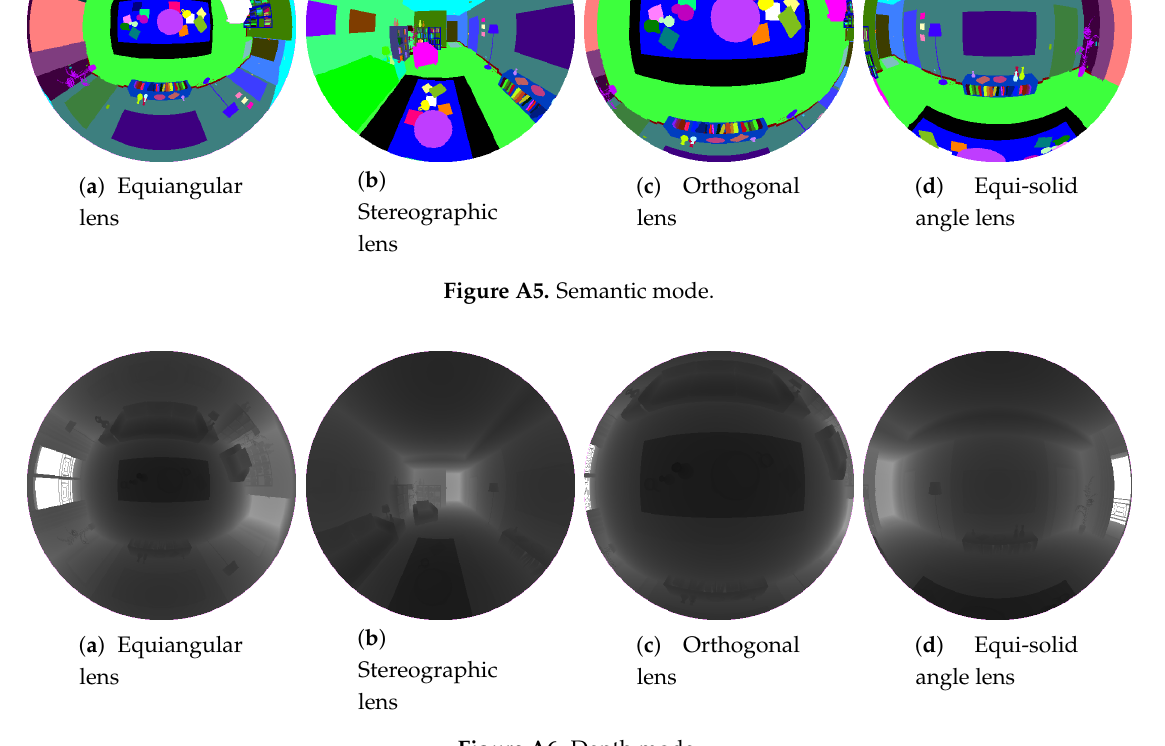
Figure A6. Depth